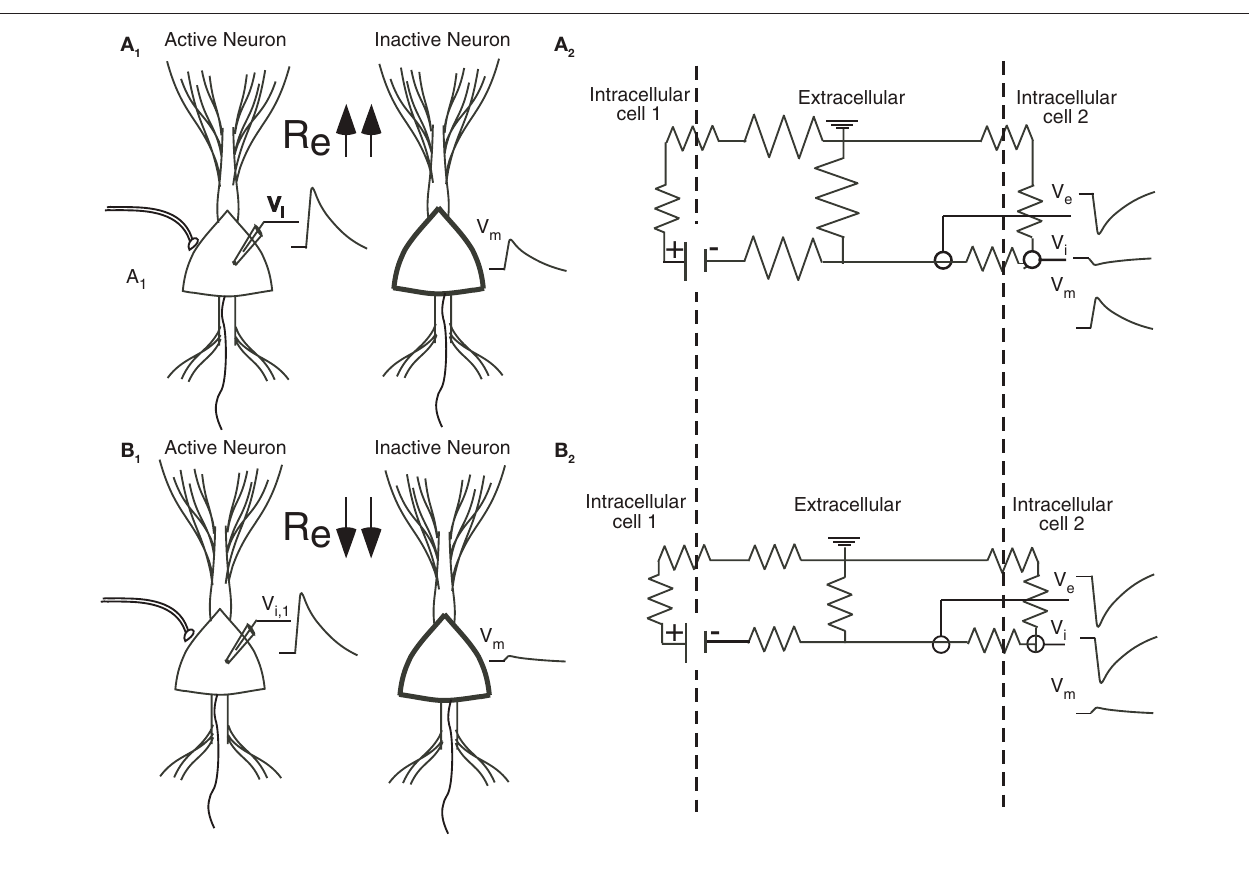
Figure 1 | (A1, B1) An ePSP in the soma of the left neuron produces a depolarization (Vm) in the soma of the right inactive neuron (thick line). The extracellular resistance (Re) is larger in (A) than in (B) . Because the resistance is higher, more current is channeled across the membrane of the cell to the right in (A) and the field effect is bigger. (A2, B2) The equivalent circuit,